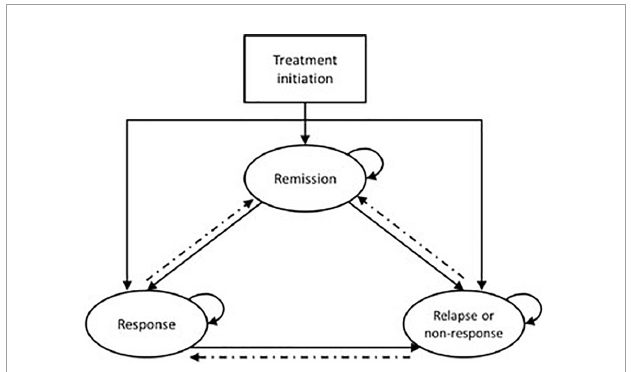
FIGURE3 Generic Markov model structure for economic evaluations in TRD. Patients solid lines indicate pathways that are common amongst the majority of models; dashed lines indicate pathways that are included in a subset of